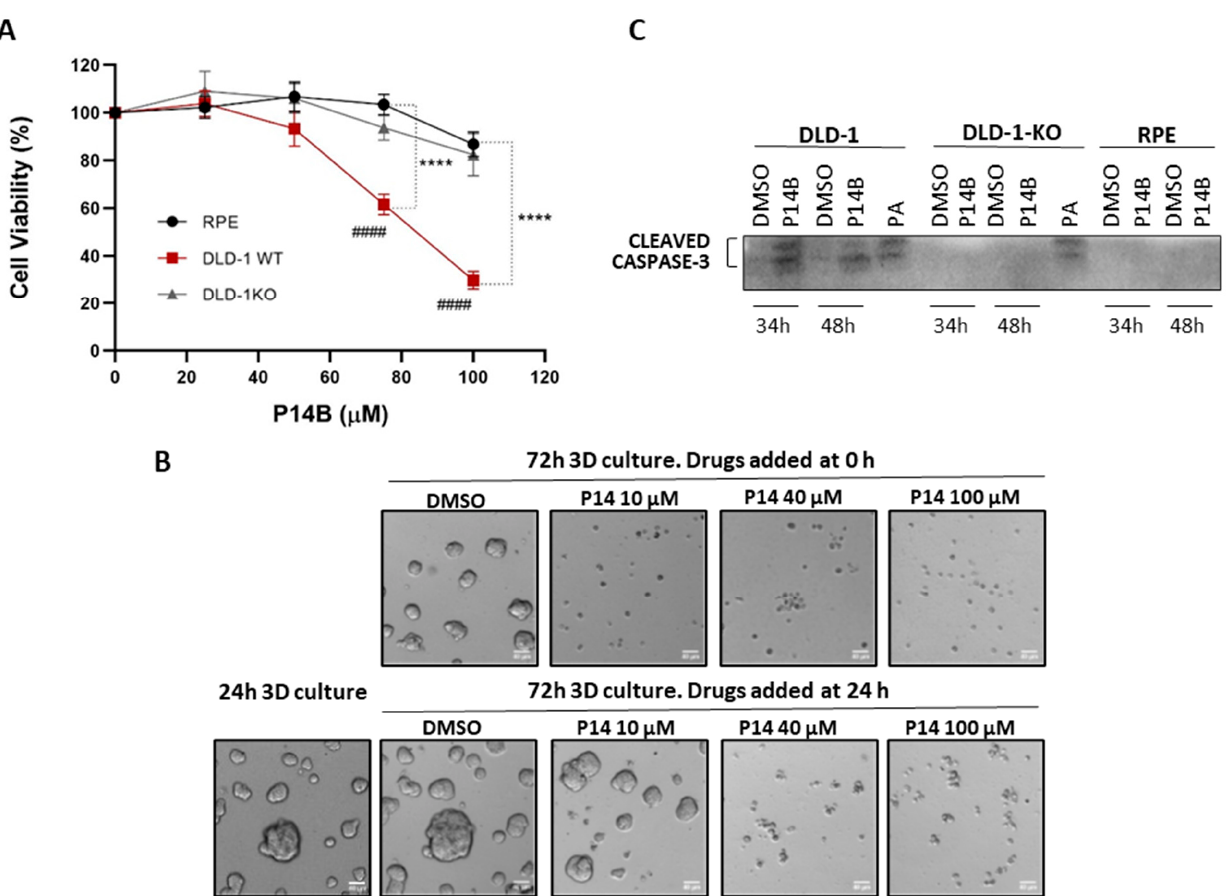
Figure 5 . P14B decreases the viability of CRC cells expressing oncogenic KRAS. ( A ) Effect of P14B on the viability of DLD-1, DLD-1-KO and hTERT-RPE cells. Cells were treated with P14B at a dose ranging from 0 to 100 µM and incubated for 24 h, at which time cell viability was determined by MTS assay. The experiment was repeated at least three times. Differences were assessed using a one way ANOVA and Multiple Comparisons Test. **** means p < 0.0001 between DLD-1 and RPE or DLD-1-KO cells; #### means p < 0.0001 between different concentrations of P14B treatment and non-treated DLD-1 cells and considered significant when p ≤ 0.05. ( B ) 2.5 × 10 4 DLD-1 cells were cultured on top of a thin basement membrane matrix (Matrigel) overlaid with a dilute solution of this matrix (3D on-top Matrigel assay). At the time of seeding or 24h later, cells were treated with P14B (10 µM, 40 µM or 100 µM), and 3 days after seeding the colonies formed were analyzed. Representative phase-contrast images are shown. All scale bars, 40 µm. ( C ) DLD-1 cells treated with P14B (100 µM) for 36 h and 48 h were lysed and the expression of the apoptosis marker cleaved caspase-3 was analyzed by WB. Cells treated with the apoptosis inducer palmitic acid (PA) were used as a positive control.